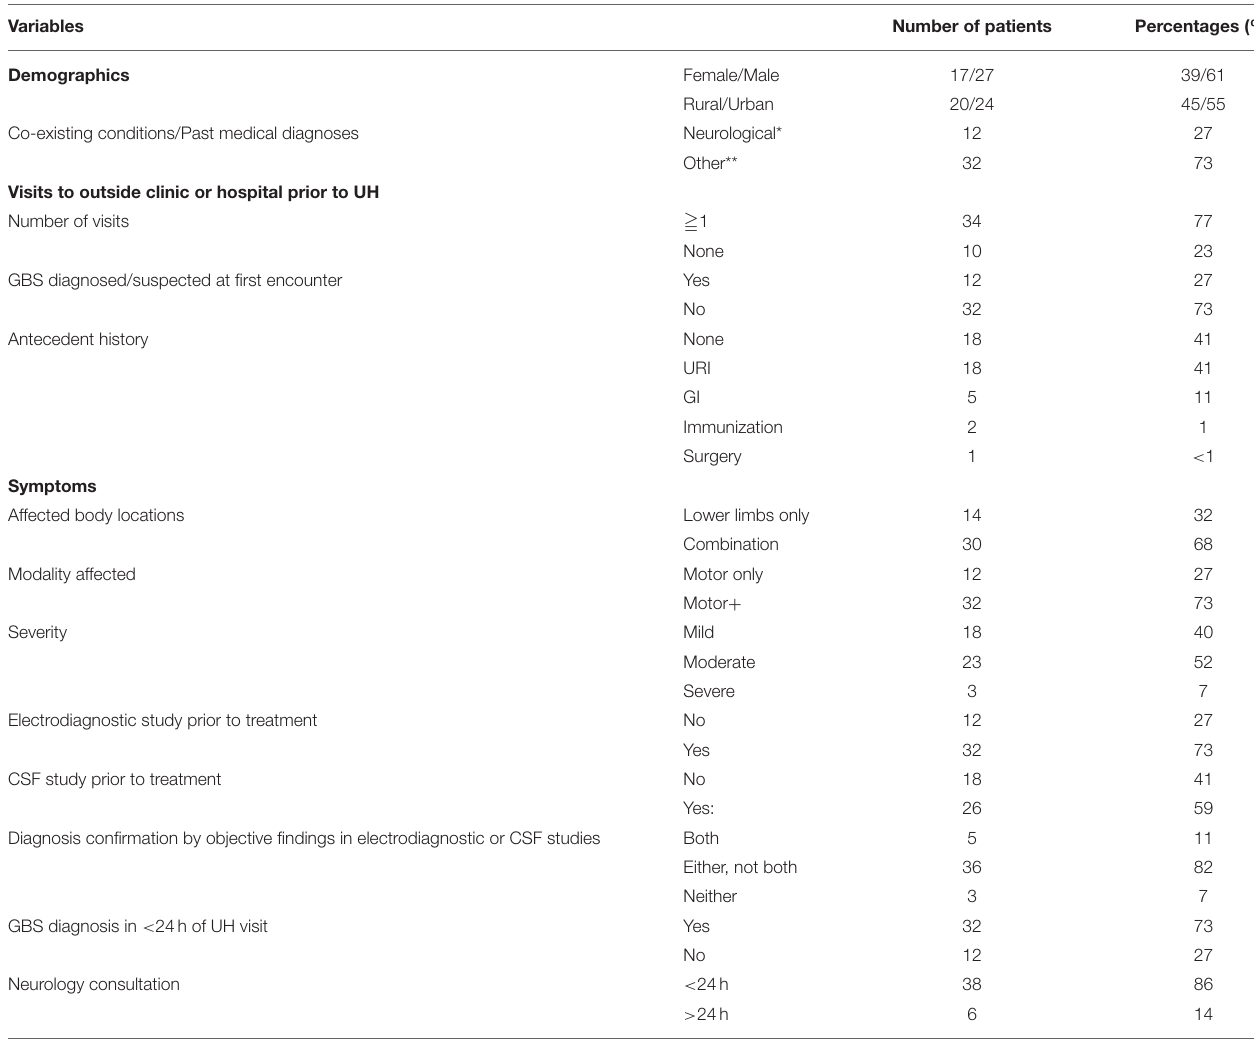
TABLE 1 | Clinical characteristics of patients with Guillain-Barre